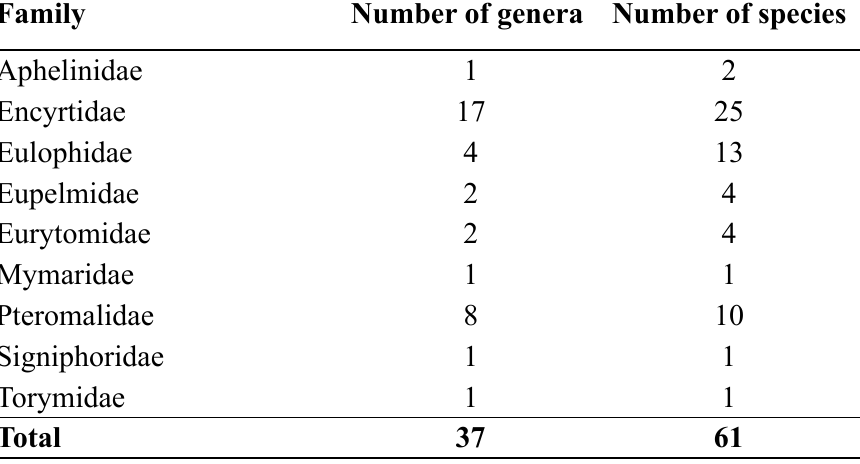
Table 1. Number of chalcid genera and species reported from Phragmites australis (Cav.) Trin. ex Steud. (Noyes